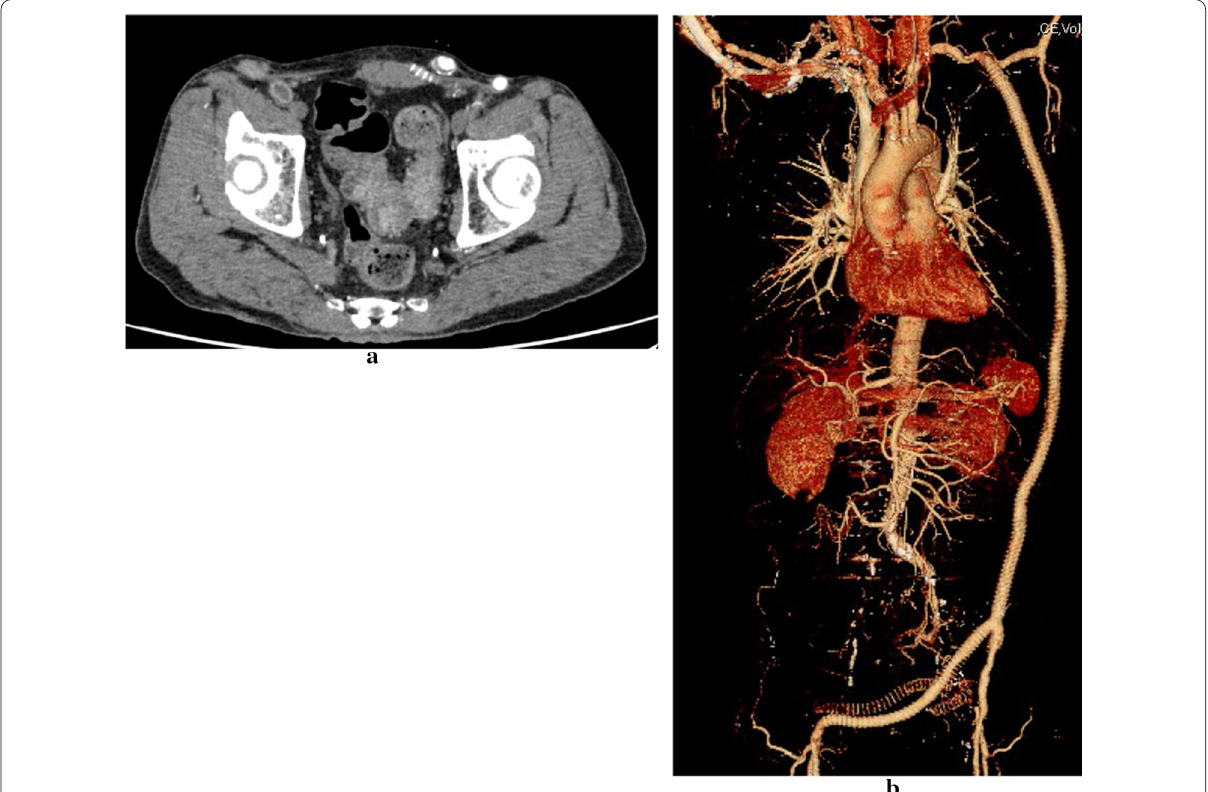
Fig. 2 a Preoperative CT. The sigmoid colon had thickened walls and increased concentration of surrounding adipose tissue, but no swollen lymph nodes around the sigmoid colon lesion. b Preoperative blood vessel construction by 3D image analysis software SYNAPSE VINCENT ® (Fujifilm,